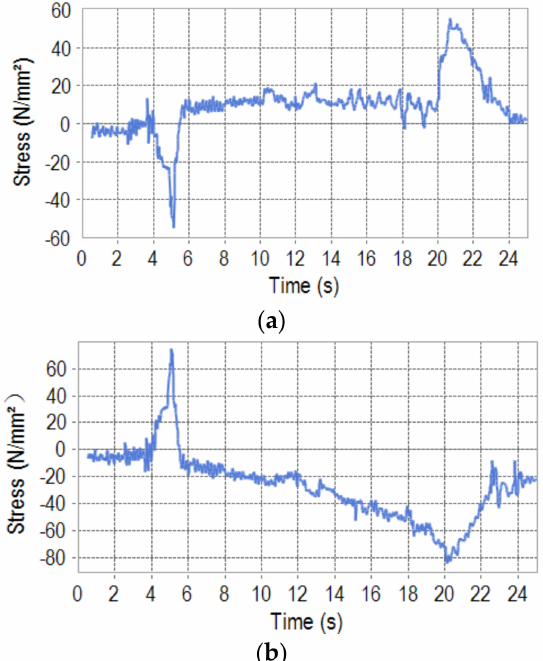
Figure 8. Stress-time histories of push arms: ( a ) left push arm; ( b ) right push